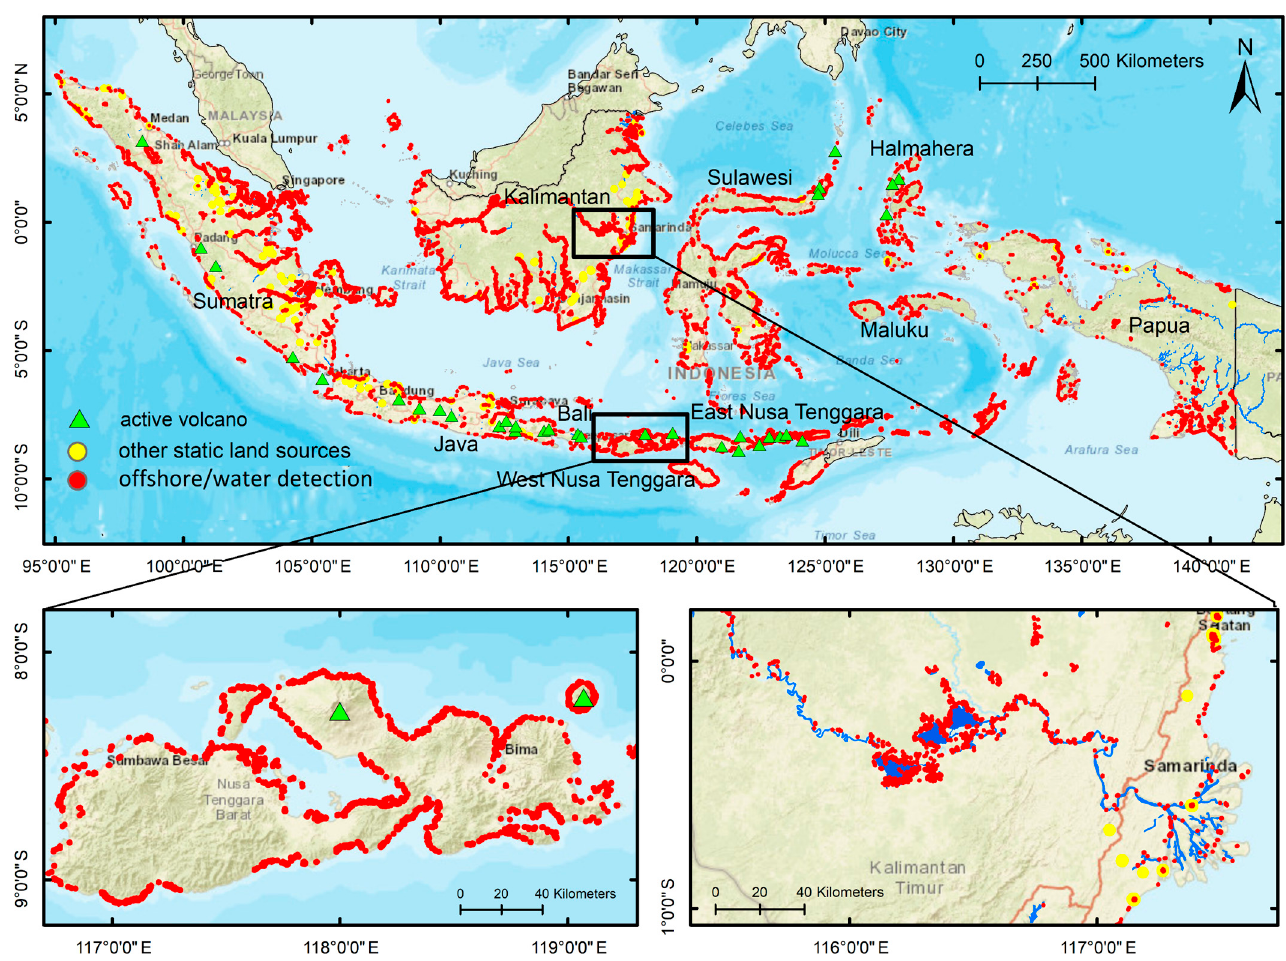
Sulawesi, and Halmahera Island (Figure 2). All the 33 clusters of type-1 were confirmed at 100% of the 33 volcanoes using high-resolution images from ESRI, Google Earth, or PlanetScope. Figure 2 shows the thermal anomaly type-2 (yellow dots) allocated to Sumatra, Kalimantan, Java, Sulawesi, Maluku, and Papua; none of them were found in Bali and Nusa Tenggara Islands. The spatial distribution of the thermal anomaly type-3, represented by red dots, generally followed the major river lines in Kalimantan and Sumatra or the coastal lines in most Indonesian islands. Examples of the enlarged image of the distribution of thermal anomaly type-3 were shown over East Kalimantan and West Nusa Tenggara Island.